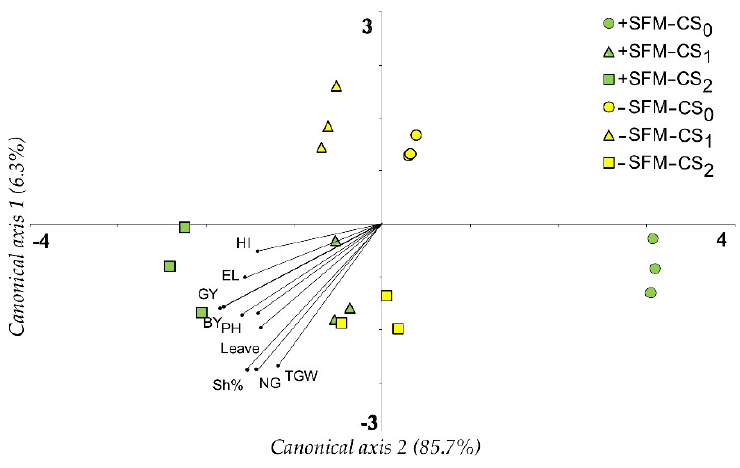
Figure 5. Biplot from the canonical discriminant analysis (CDA) of sugarcane filter mud and compost source effects on sweet maize yield characteristics. − SFM = sugarcane filter mud not applied; +SFM = sugarcane filter mud applied; CS 0 = control treatment with no CS input; CS 1 = crop residues (Brassica residue); CS 2 = domestic wastes (Household waste); PH = plant height; EL = ear length; Leave = number of leaves; LA = leaf area per plant; TGW = thousand grains weight; SH% = shelling percentage; NG = number of grain; GY = grain yield; BY = biological yield; HI = harvest index.